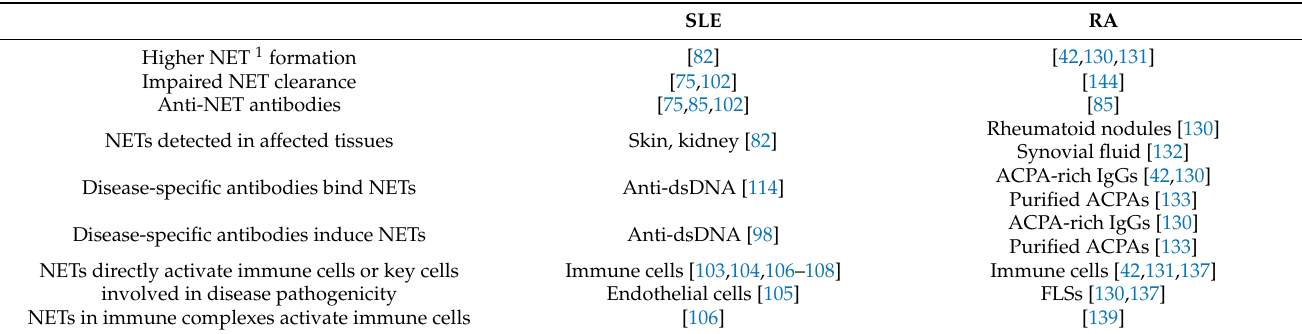
Table 2. Involvement of NETs in SLE and